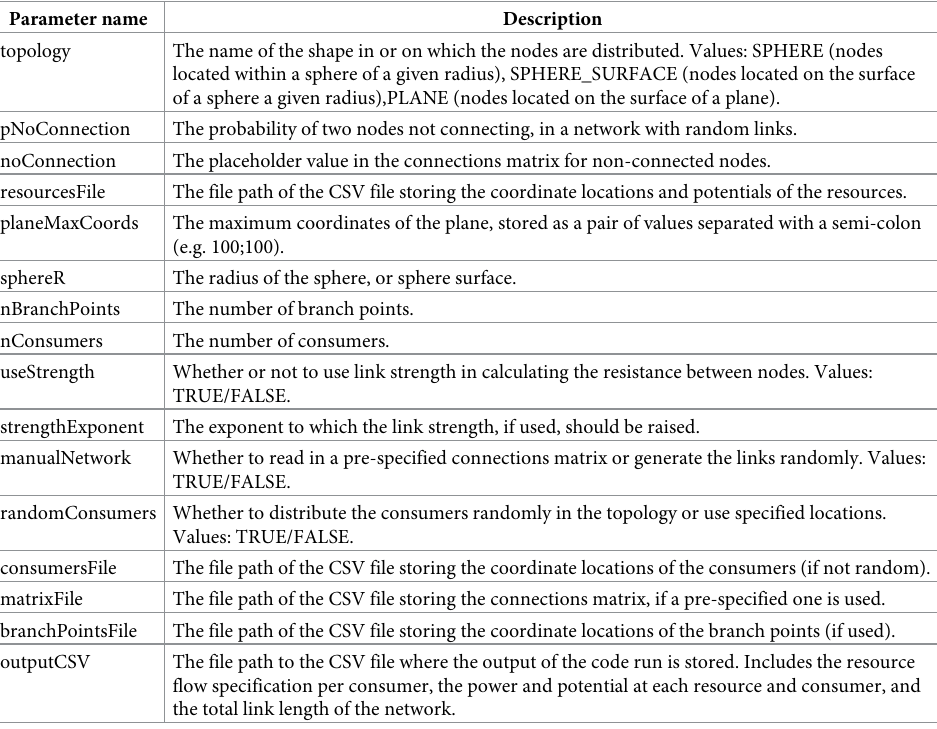
Table 1. Modified load flow methodology input parameters and